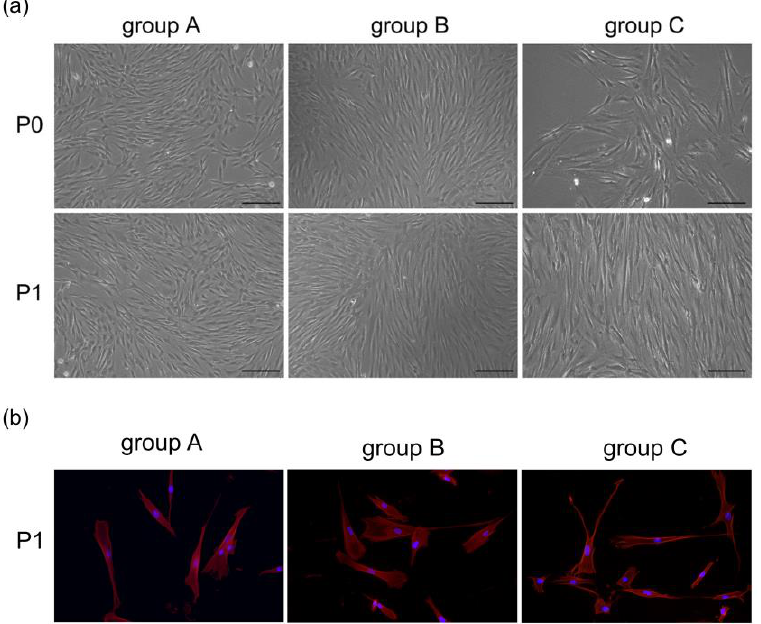
Figure 2. ( a ) Morphological features of hDPSCs at primary and passage 1 under an inverted micro- scope (scale bar: 200 µ m). ( b ) Cells at passage 1 were stained with fluorophore-conjugated phalloidin (red) and DAPI nuclear counterstain (blue). The cells were spindle shape and radially arranged from the center of the tissue block. In group C, certain cells became more elongated and irregular.